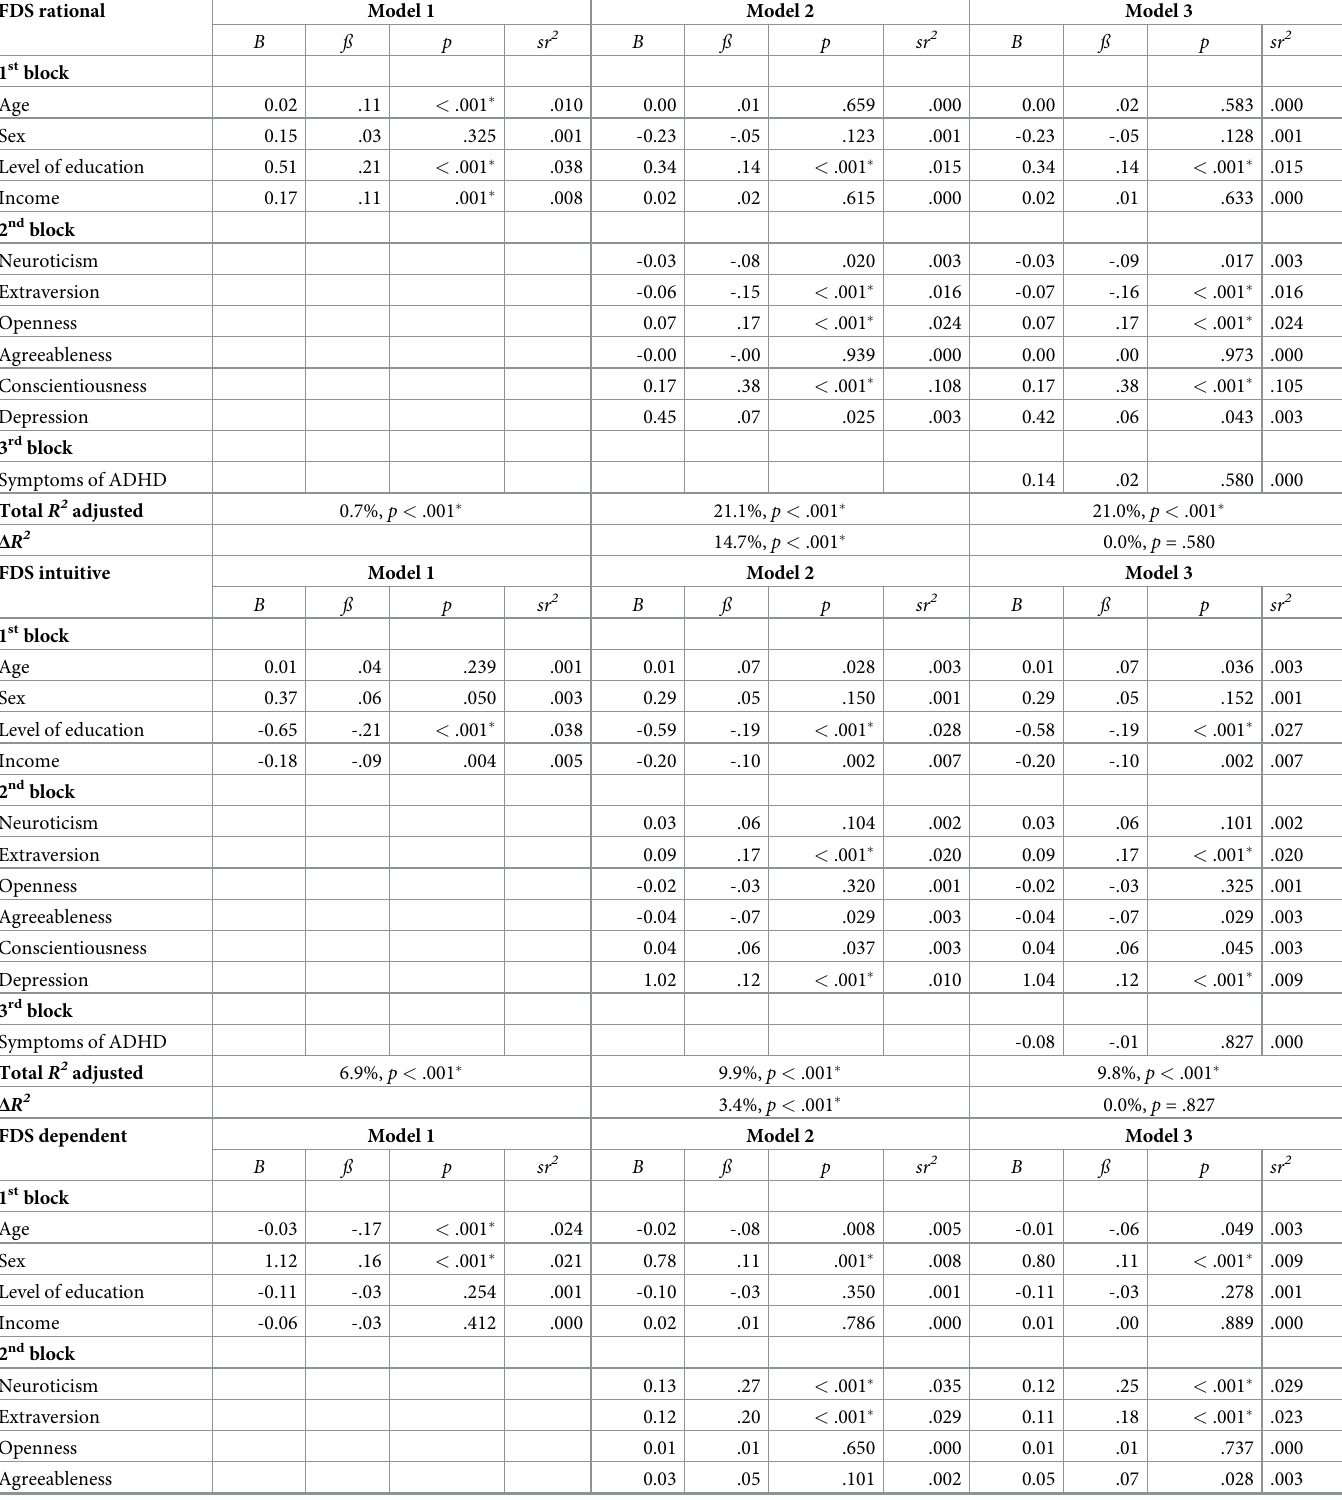
Table 5. Hierarchical regressions of financial decision-making styles in the total